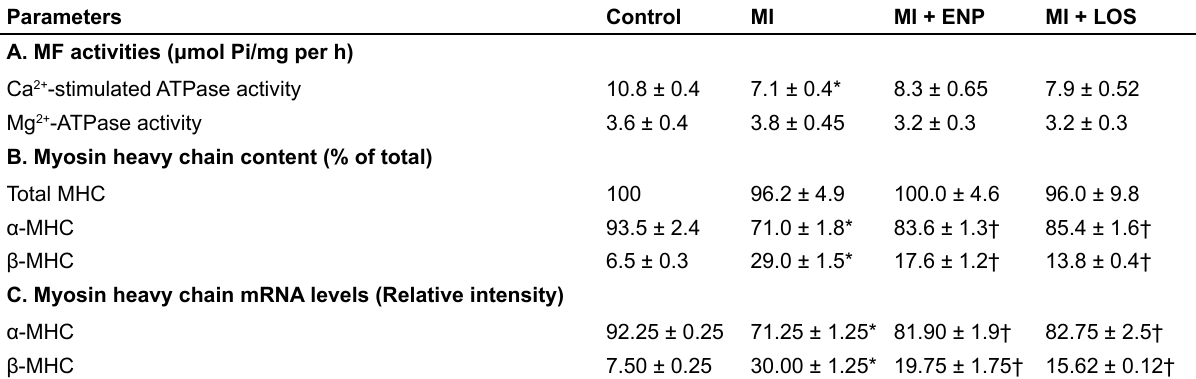
Table 3. Myofibrillar ATPase activities, protein content and mRNA levels in control and MI animals with or without ENP and LOS for 5 weeks starting at 3 weeks after induction of MI